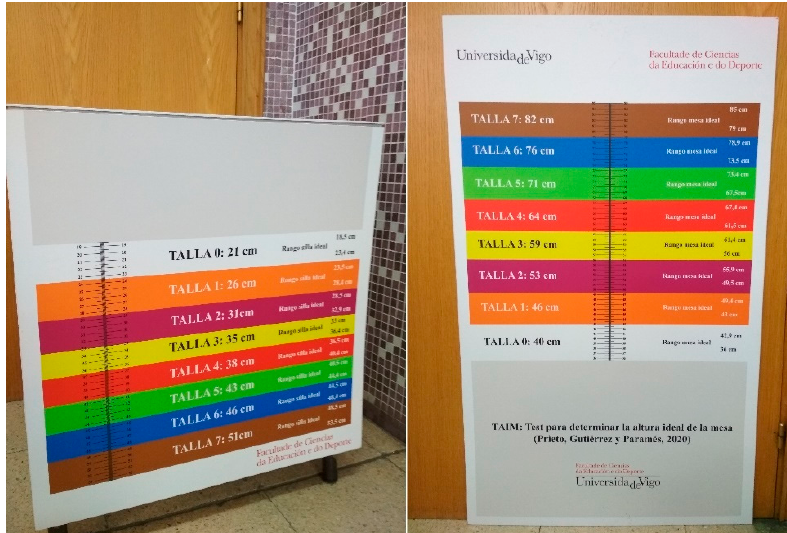
Figure 1. Measuring tool ISHT and